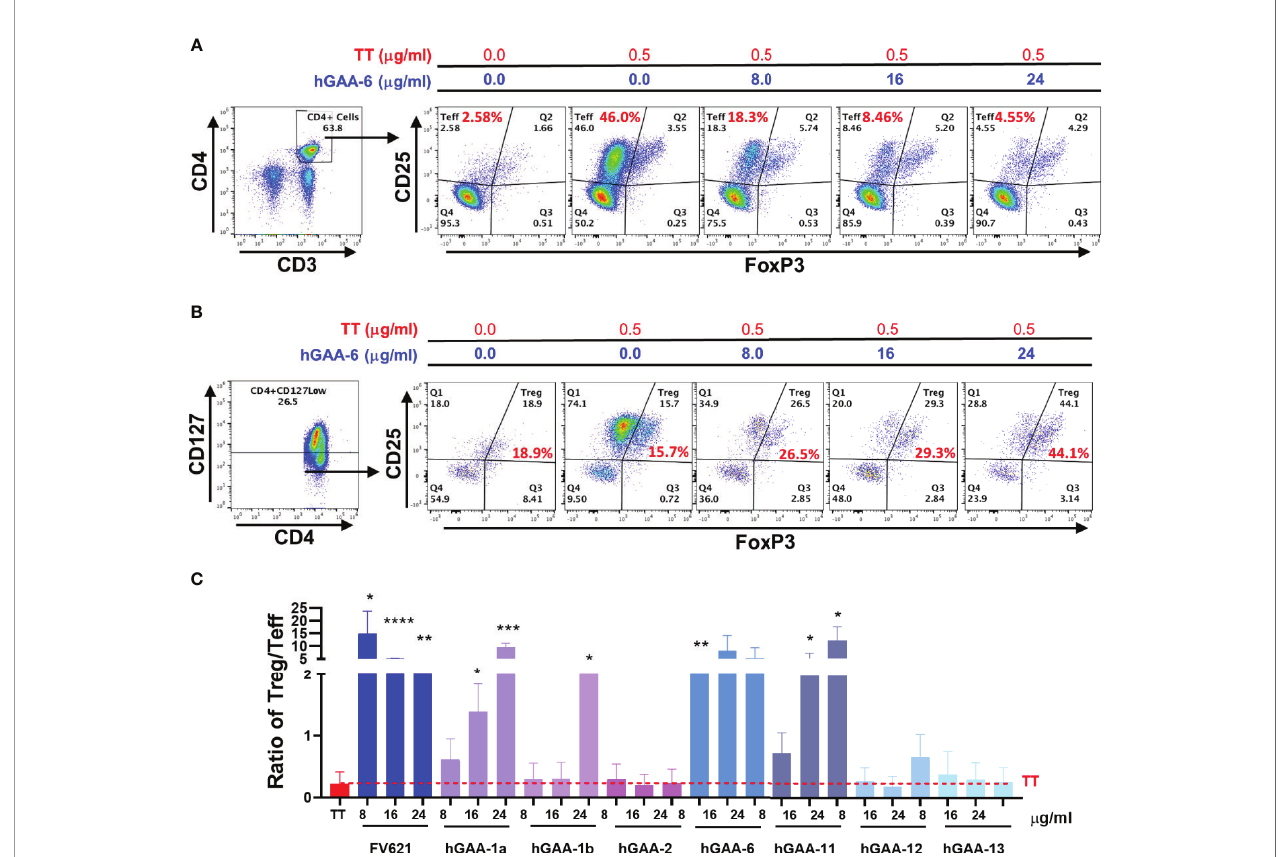
FIGURE 6 | GAA-peptides modulate T regulatory to T effector cell ratio. Healthy donor PBMCs were stimulated with Tetanus Toxoid (TT) with or without GAA-selected peptides for 7 days and analyzed by fl ow cytometry. (A) Representative fl ow cytometry dot plots show the effect of hGAA-6 peptide on the inhibition of T effector (CD4+CD25 hi FoxP3 int ) cells for a single donor. (B) The effect of hGAA-6 peptide on regulatory T cells (CD4+CD127 low CD25 hi FoxP3 hi ) in the representative donor is shown. (C) Representative histogram indicates the effect of selected GAA peptides on the Treg to Teff ratio in an individual donor. GAA peptides 1a, 1b, 6 and 11 signi fi cantly increased the Treg : Teff ratio similar to the FV621 Tregitope control. P values * ≤ 0.05, ** ≤ 0.005, *** ≤ 0.0005 and **** ≤ 0.00005 represents statistical signi fi cance between peptide stimulation at a given concentration vs TT using a two-tailed t